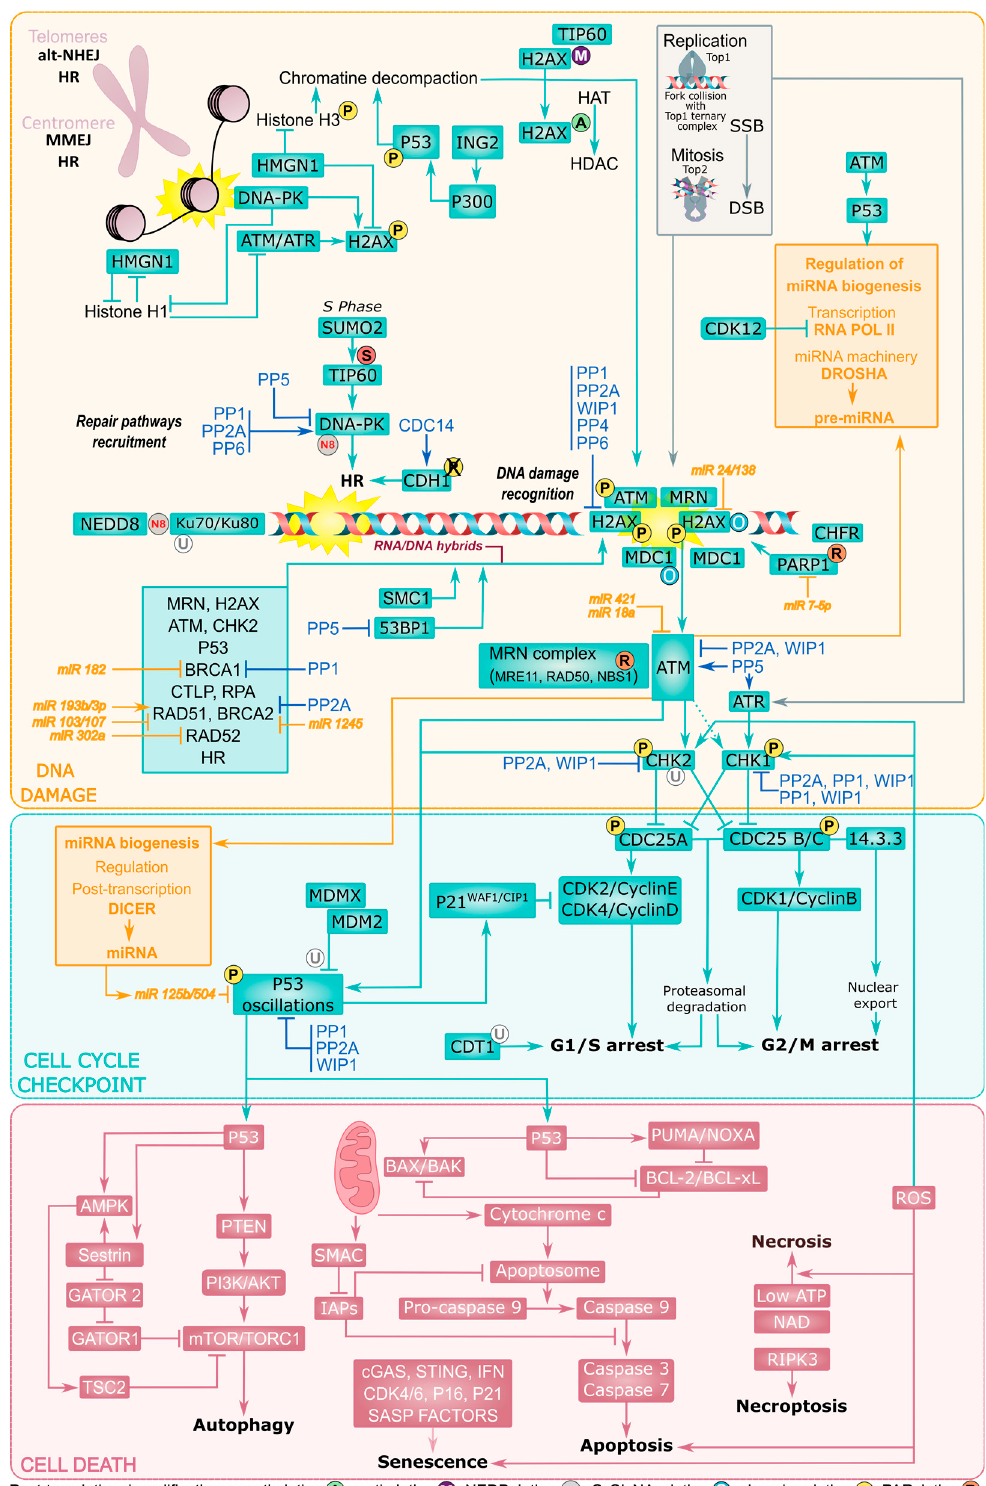
Figure 2. Regulation of the DNA damage signaling network of proteins. In the yellow panel: after DNA damage, induced for example by topoisomerases misregulation, repair pathways are selected, and major sensors/effectors are recruited to the damaged lesions. These recruitments are accompanied by many post-translational modifications of proteins with major impacts on the cell response to DNA damage, e.g., O-GlcNAcylation of H2AX and NDC1 at the DNA damage repair site, ubiquitination and NEDDylation of Ku70/80 from the NHEJ and/or PARylation of NBS1 in the MRN complex from HR, and sumoylation of TIP60 in HR. The chromosomal state and the regions damaged mobilize different repair processes that are facilitated by chromatin decompaction through the action of HMGN1 on histone H3, histones